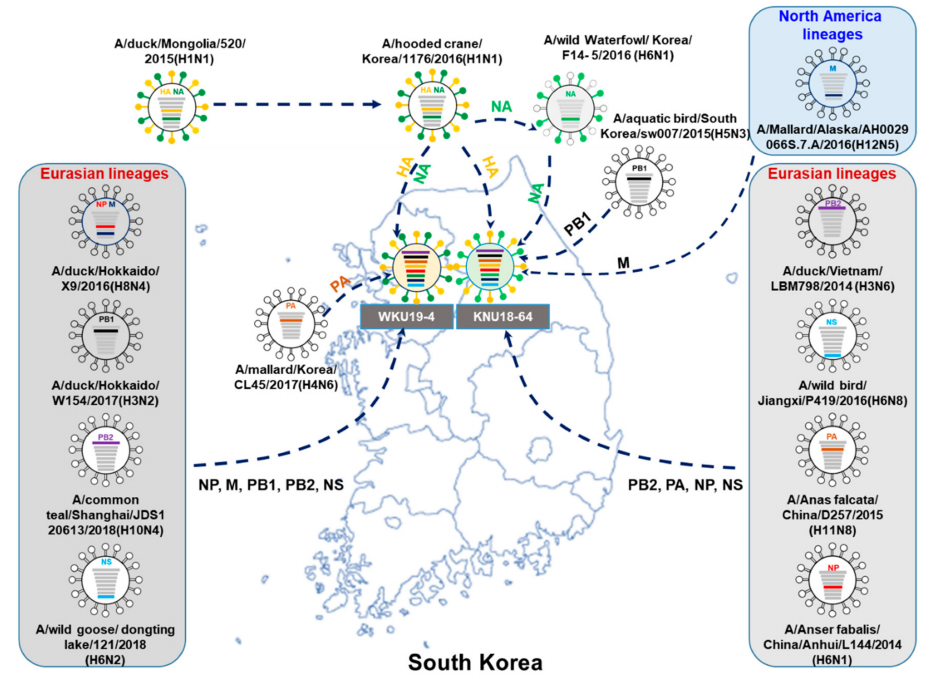
Figure 1. Putative origins of the genes comprising the KNU18-64 (A/ Greater white-fronted goose /South Korea/KNU18- 64/2018(H1N1)) and WKU19-4 (A/wild bird/South Korea/WKU19-4/2019(H1N1))